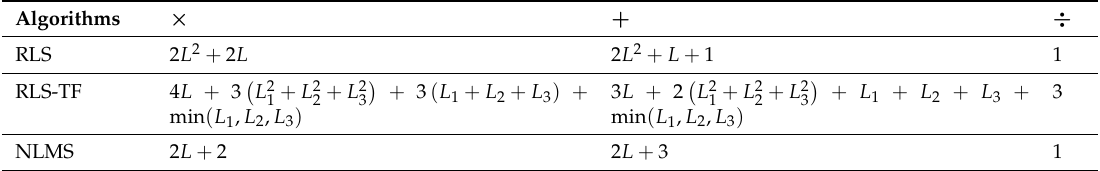
Table 2. Computational complexity of the RLS-TF algorithm, as compared to the conventional RLS and NLMS